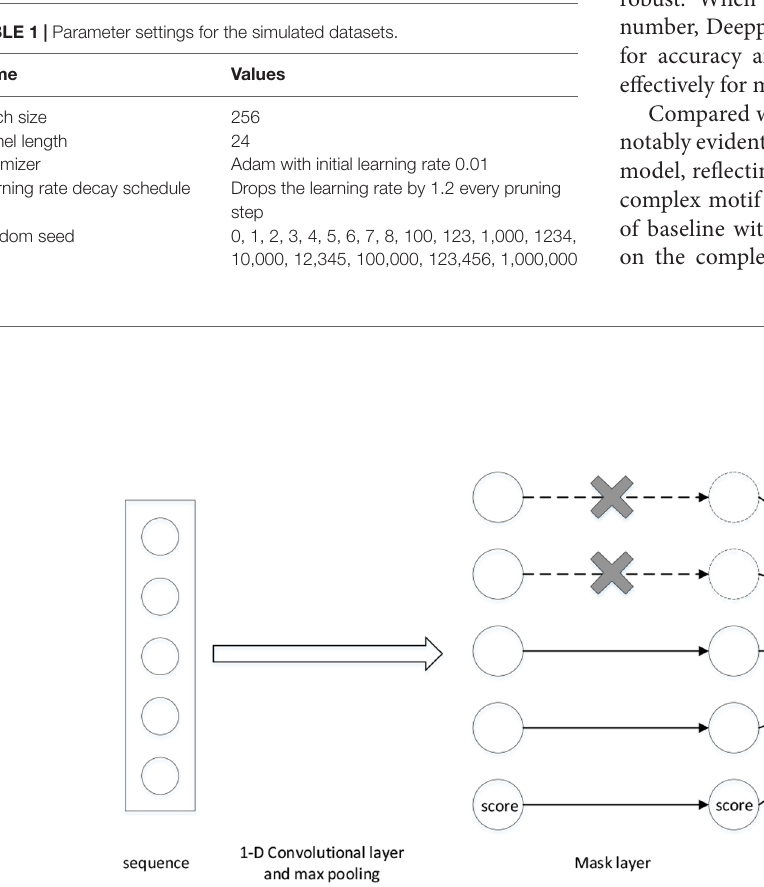
FIGURE 1 | The architecture of Deepprune. The first layer is a convolutional layer. The second layer is a rectified linear units activation function followed by global max pooling. A mask layer is added to prune the small-magnitude weights. The fourth layer is a dense layer which linearly combines the outputs of all the kernels. The last layer is a sigmoid activation function which converts the values obtained in the dense layer to a value between 0 and 1 which corresponds to a probability. Three pruning strategies are designed for Deepprune with different modes.